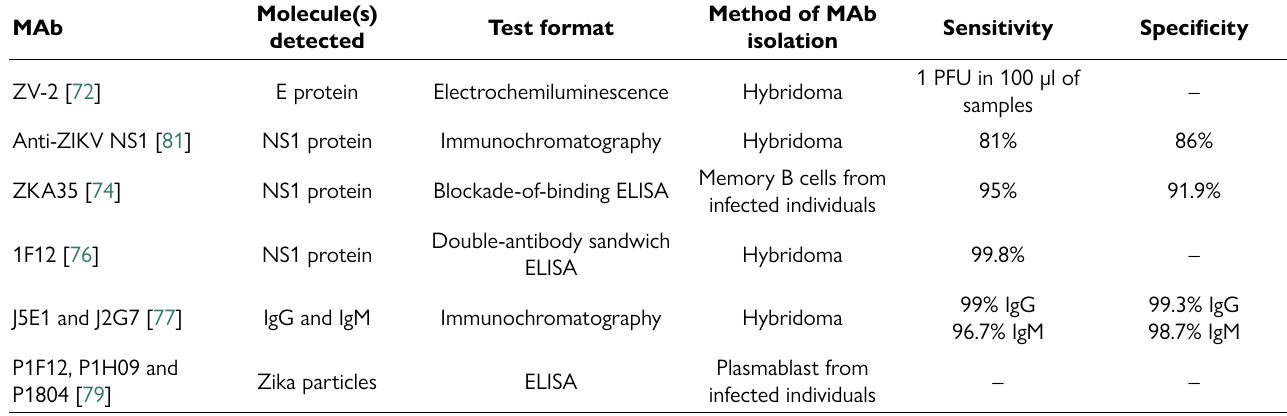
Table 3. Monoclonal antibodies used in ZIKV diagnostic